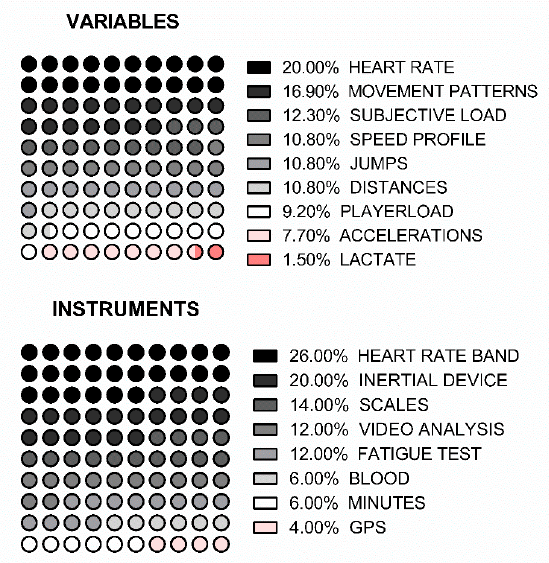
Figure 7. Distribution of instruments and variables.